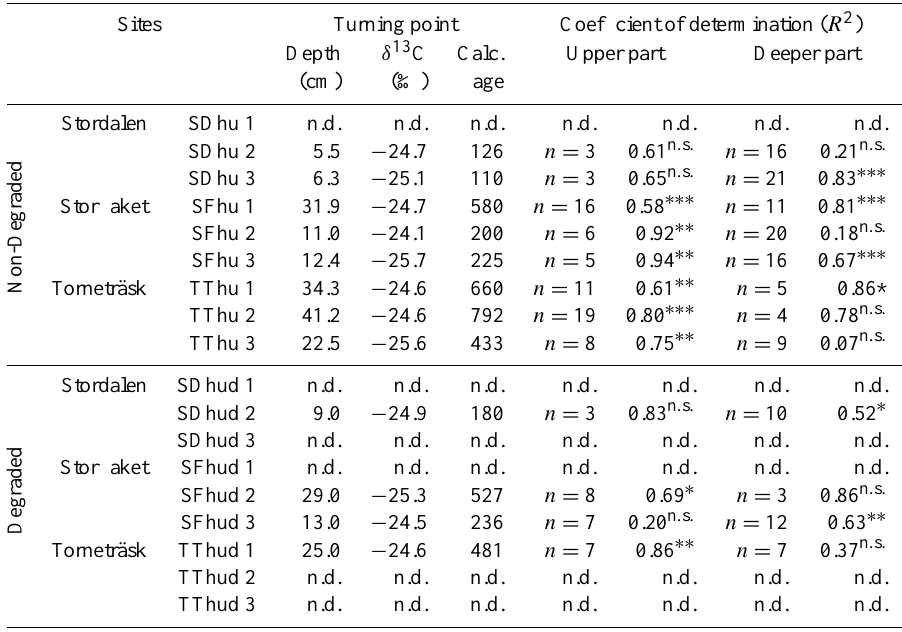
Table 1. Regression analyses of δ 13 C and depth at hummocks (hu) and hummocks (hud) degraded of the peatlands Stordalen (SD), Storflaket (SF) and Torneträsk (TT) with “turning points” and calculated ages of the “turning points”. Sites Turning point Coefficient of determination ( R 2 ) Depth δ 13 C Calc. Upper part Deeper part